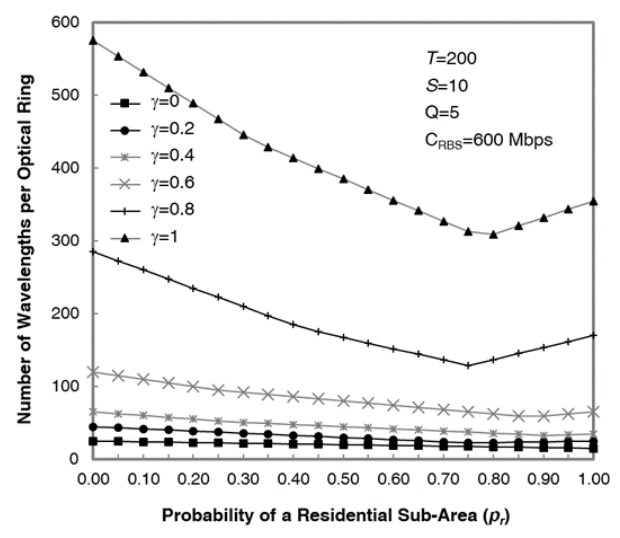
Figure 7. The number of wavelengths per optical ring is reported as a function of the probability p r of residential sub-area. The percentage γ of used RRUs is varied from 0 to 1. The peak offered traffic is A o , b = 26 Gbps and A o , r = 16 Gbps for business and residential sub-area, respectively. R = 2 optical rings are considered. The values of the other parameters are chosen as the ones in Figure 5.